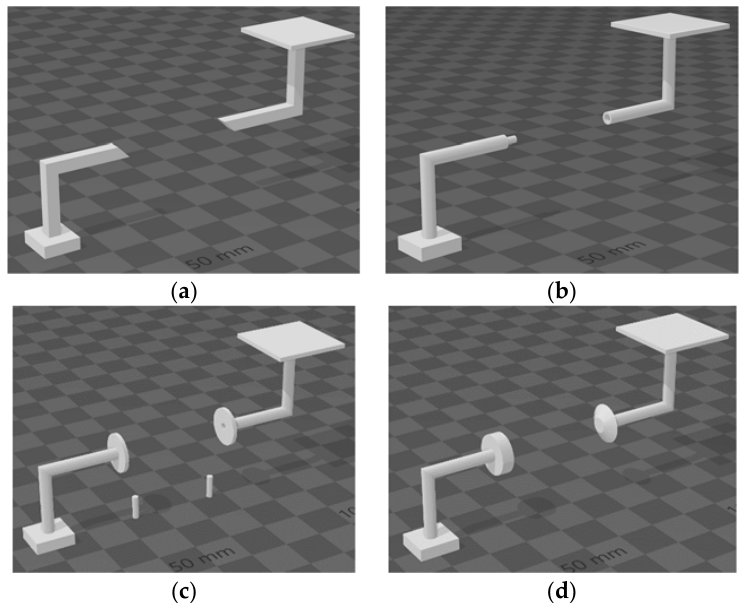
Figure 3. Modelled designs for conducting an electrical signal between distinctive parts of a 3D model. ( a ) Sloped surfaces proved to be an invalid solution. ( b ) Another non-functional solution, given by the imprecisions of 3D printing. ( c ) A valid solution, but also influenced by imprecisions and absent model parts, as described in the text above. ( d ) A valid solution; the shape of either side is not prone to imprecisions that stem from 3D